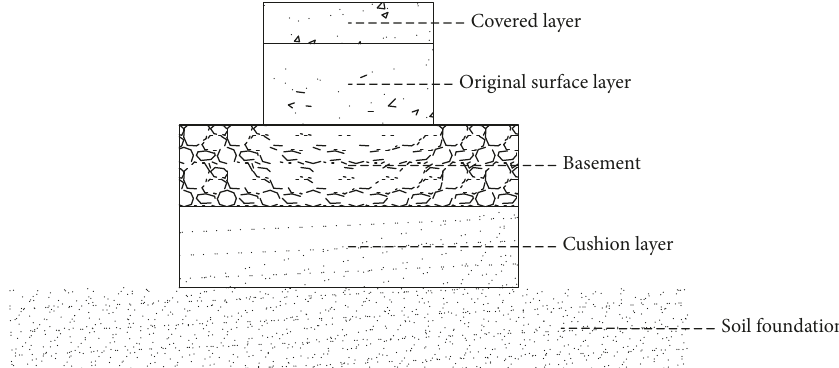
Figure 1: The ACCDDPS